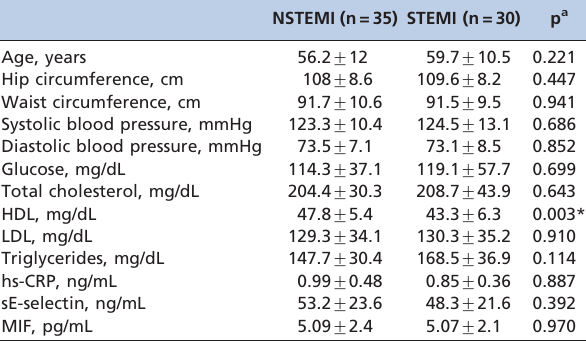
Table 2 - Demographic and biochemical characteristics of the patients with mild or severe coronary artery